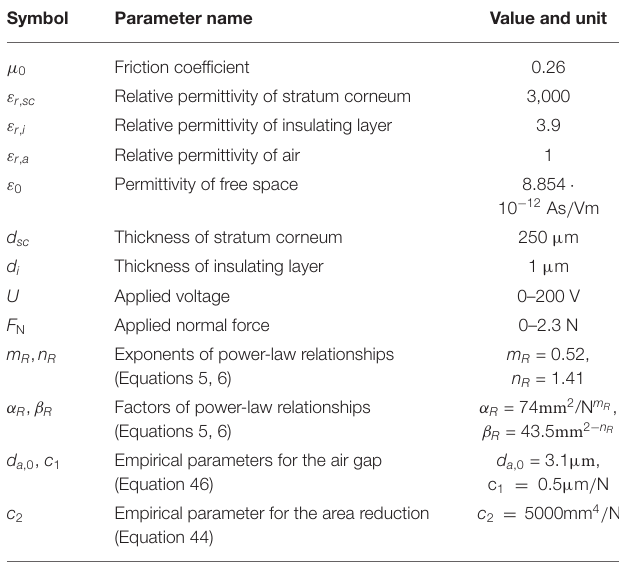
TABLE 1 | Parameters used for the model of sliding